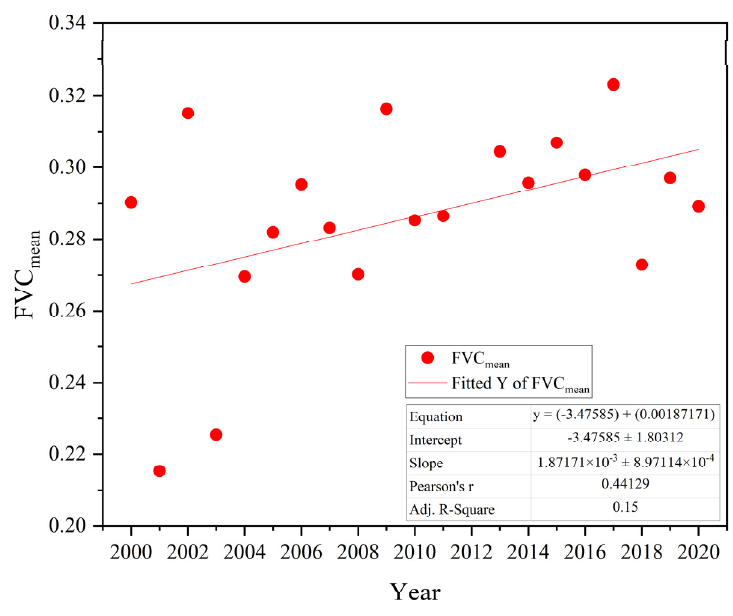
Figure 2. Changes and trends of FVC mean from 2000 to 2020.